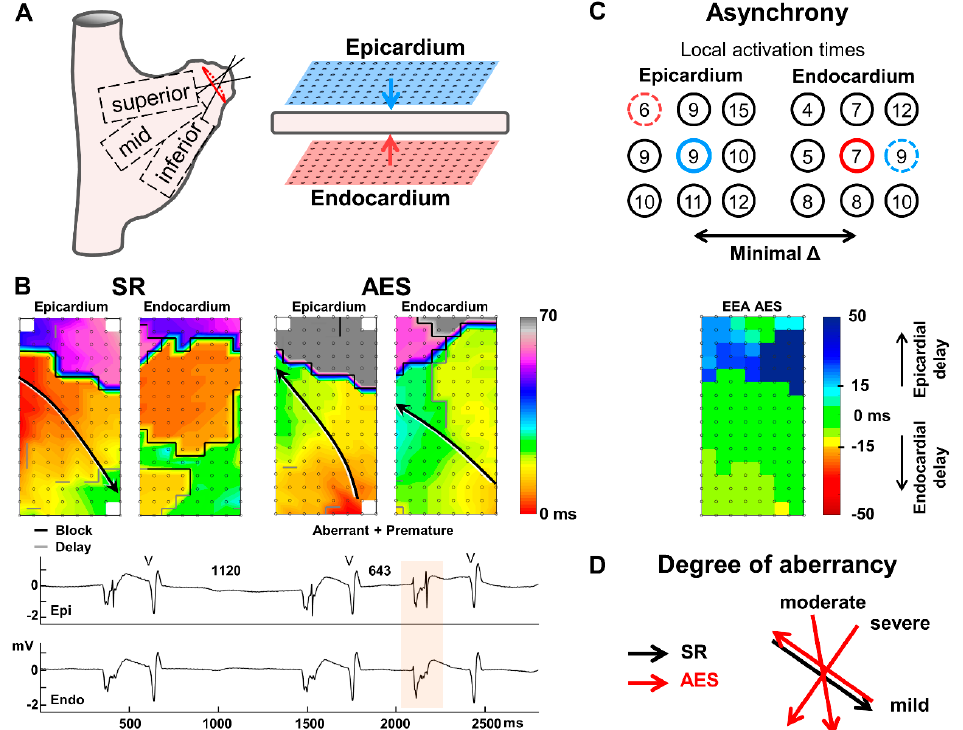
Figure 1. Endo-epicardial mapping and data analysis. ( A ) endo-epicardial mapping was performed with two 128-electrode arrays, one placed on the epicardium and one on the endocardium. Recording locations included (1) the superior right atrium (RA), (2) the mid RA and (3) the inferior RA. ( B ) endo-epicardial activation maps of a sinus rhythm (SR) beat and an atrial extrasystole (AES) show the aberrant activation pattern of the AES, at the epicardium there is mild aberrancy (180 ◦ shift of the main wavefront trajectory), at the endocardium there is a complex pattern of activation during sinus rhythm without a main trajectory. Conduction block ( ∆ > 11 ms) or delay (7–11 ms) between two electrodes represents a line of 2mm. The total length of all lines represents the amount of conduction block and delay. Epi- endocardial electrograms demonstrate the AES is premature as well, with a 57% shortening of the cycle length. V = ventricular activation. ( C ) endo-epicardial asynchrony (EEA) is determined by the minimal local activation time di ff erence between the nine opposite electrodes and the index electrode (center). Electrodes at the border of the array only have ≤ 6 opposite electrodes and are excluded. At the epicardium the minimal di ff erence is 0 ms (blue), in this example, at the endocardium the minimal di ff erence is − 1 ms (red). The maximal di ff erence of two opposite electrodes is shown in the EEA map. Positive values represent an epicardial delay in activation and negatives values an endocardial delay in activation. ( D ) degree of aberrancy is categorized based on the rotational shift of the main trajectory of the AES wavefront; mild 180 ◦ , moderate 45 ◦ / 135 ◦ , severe 90 ◦